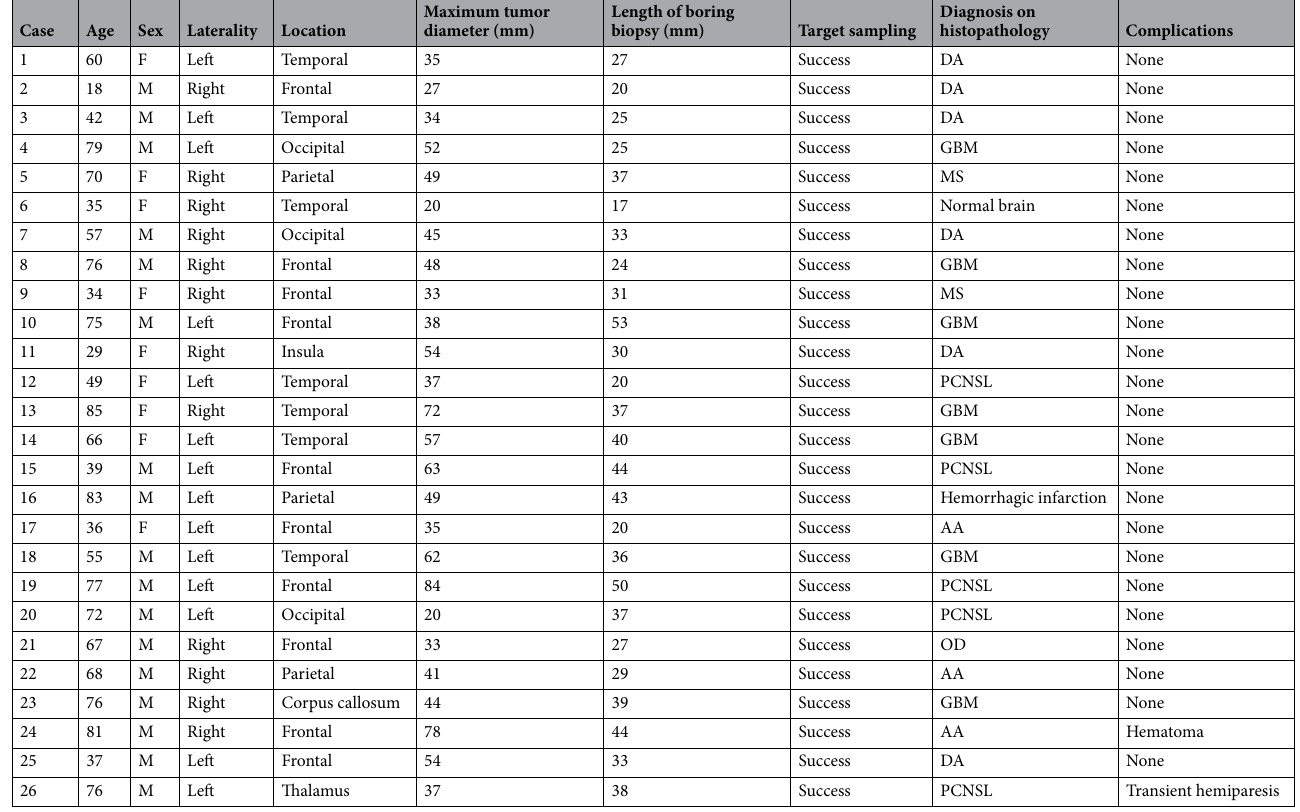
Table 1. Clinical characteristics of 26 patients with intraparenchymal brain lesions who underwent boring biopsy. F female; M male; DA diffuse astrocytoma; GBM glioblastoma multiforme; MS multiple